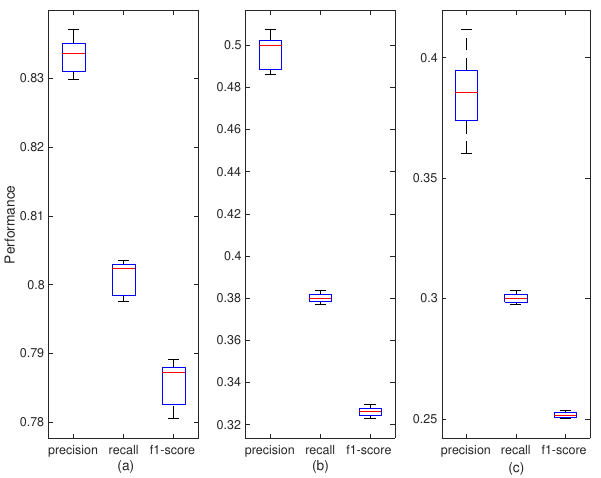
Figure 8. Impact of number of encrypted fields. The ( a – c ) individually represent the performance in three situations including encrypting the vht field only, two fields including vht and ht and all